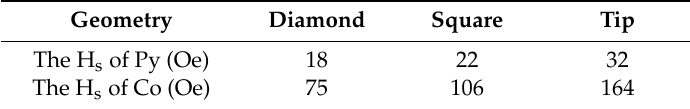
Table 1. The average switching field for the three di ff erent